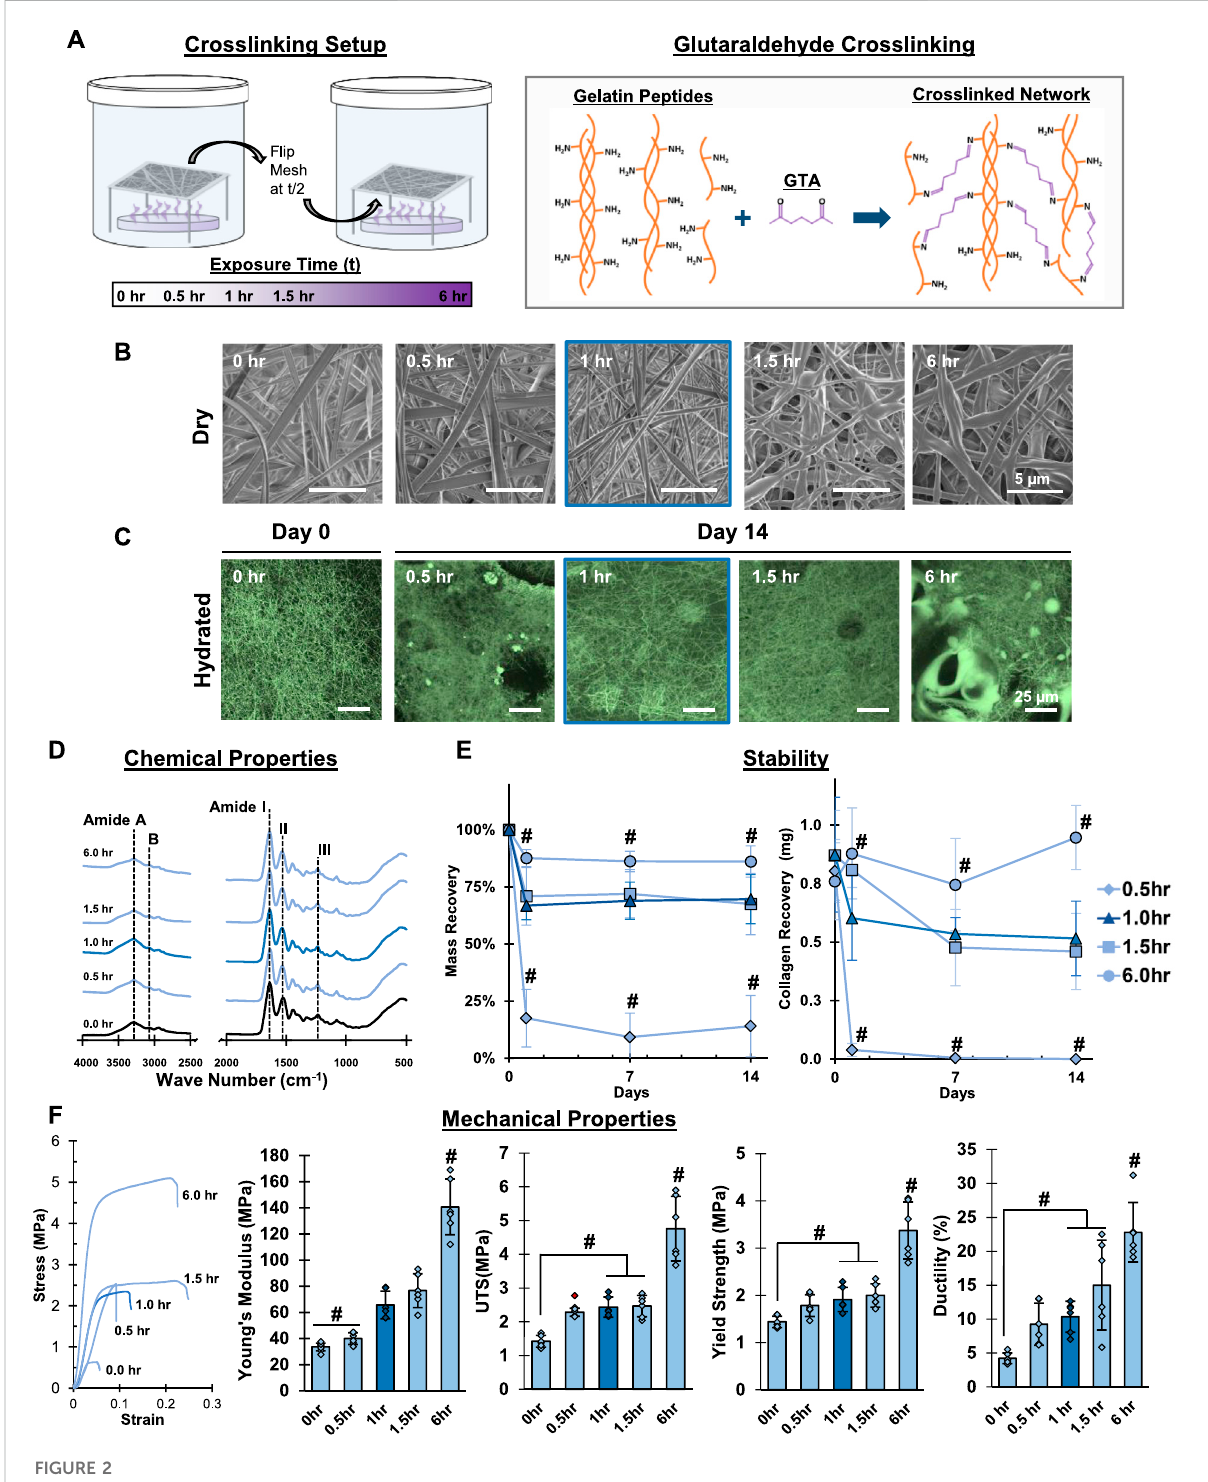
FIGURE 2 Mesh Fabrication: Crosslinking Duration. Glutaraldehyde exposure for 1 hour stabilizes meshes and enhances tensile properties without changing fi ber morphology orchemistry. (A) Schematic of thecrosslinking procedureand chemicalreaction. (B) Drymorphology (SEM, 5,000x) and (C) hydrated morphology (CRM, 100x) of meshes after crosslinking. (D) Chemical composition (FTIR-ATR). (E) Mesh stability by mass recovery and gelatin recovery after incubation at 37 ° C in cell culture medium (14 days, n = 5). (F) Mesh tensile properties ( n = 10). Red marker indicates outliers. #= p <